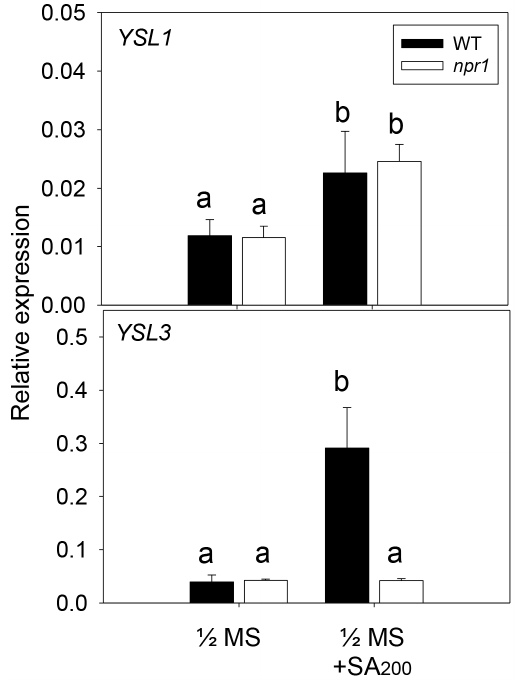
Figure 2. Effect of exogenous SA on the expression of YSL1 and YSL3 in A. thaliana Col-0 and the npr1 mutant. Twelve-day-old plants of A. thaliana Col-0 wild type (WT) and npr1 mutant were treated with 200 m M SA for 24 h. qPCR analysis of expression of YSL1 and YSL3 in shoots relative to that of ACT2 . Data are mean 6 SD 9 samples from 3 biological replicates. Different letters indicate significant difference